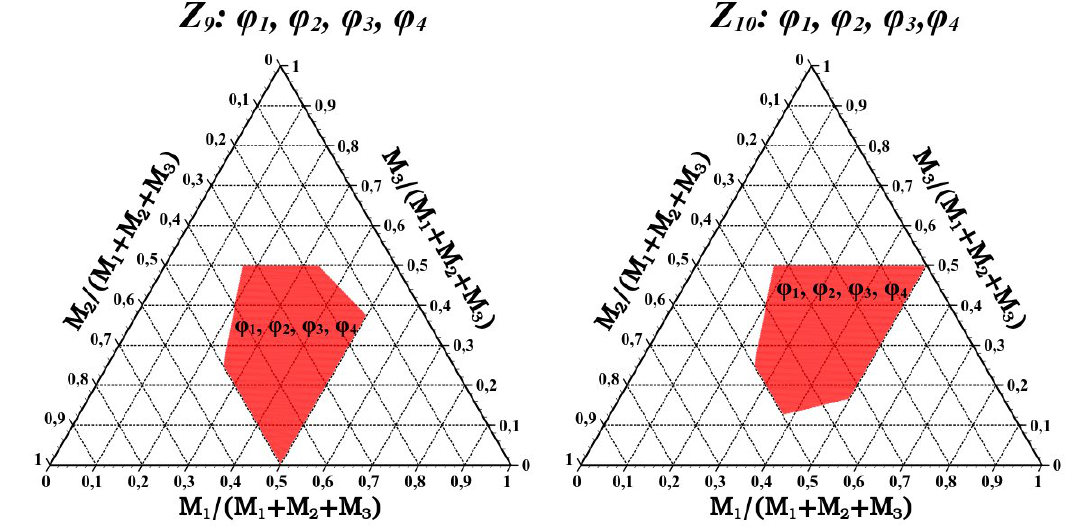
Figure 6 . The region where the four (cid:12)elds (cid:30) 1 ; (cid:30) 2 ; (cid:30) 3 ; (cid:30) 4 can be stable for a Z 9 (left panel) and a Z 10 (right panel) symmetry. Inside the colored region it is possible to (cid:12)nd a value of M 4 such that all four (cid:12)elds are